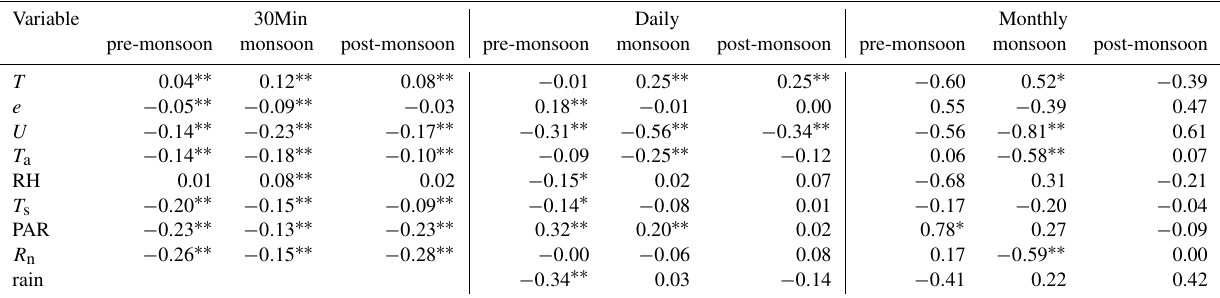
Table 4. The Pearson correlation coefficients between 30Min, Daily and Monthly CO 2 flux and difference between water surface and air temperature ( (cid:49)T ), vapor pressure difference ( e ) between water surface and the air, wind speed ( U ), air temperature ( T a ), relative humidity (RH), water surface temperature ( T s ), photosynthetically active radiation (PAR), net radiation ( R n ), and rain, during pre-monsoon, monsoon and post-monsoon periods for the whole study period (2012 to 2015). The significant levels of 0.01 and 0.05 are marked with ∗∗ and ∗ , respectively. The correlation coefficients between rain and CO 2 flux are estimated only at daily and monthly